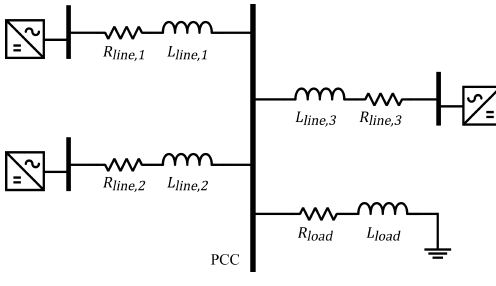
Figure 2. VSI-MG Test Network. Table 1. Network and VSI Model Parameters.